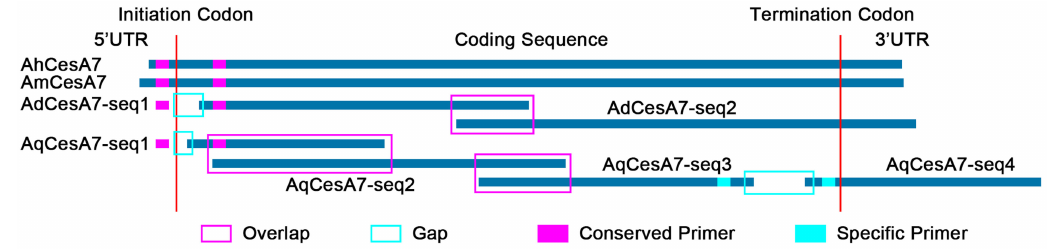
Figure 3. A sketch map for the cloning of cellulose synthase genes (CesA) in Agave plants ( CesA7 as an example).